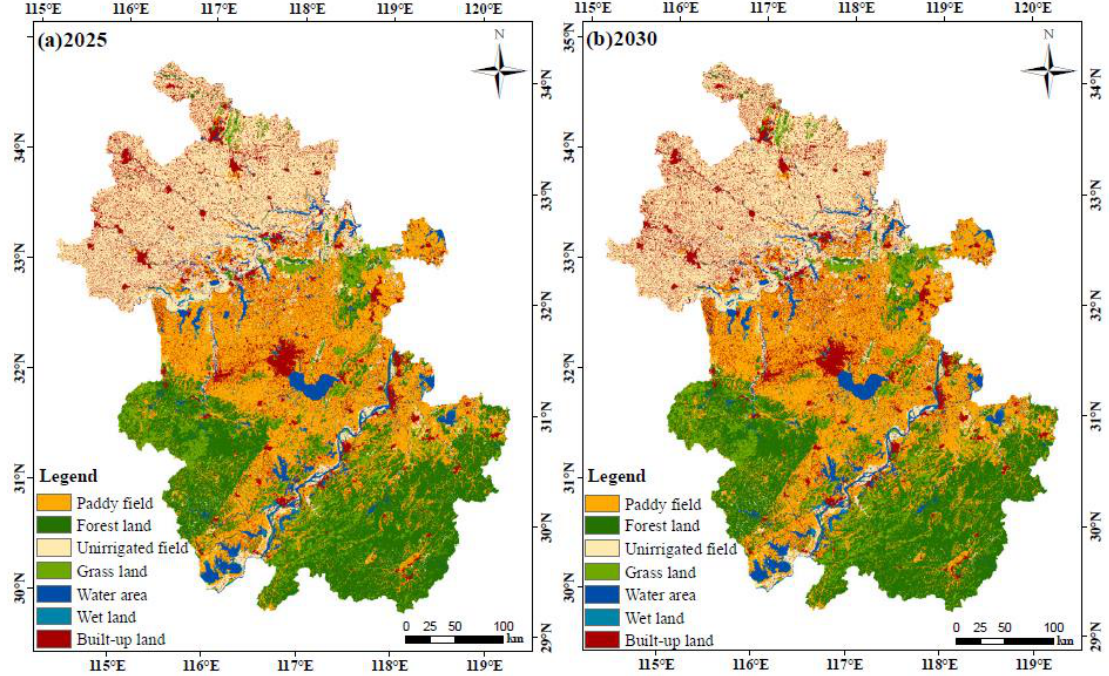
Figure 5. Simulation results of land use spatial layout in ( a ) 2025 and ( b ) 2030 using the FLUS model. Table 13. Simulation results of land use change in 2025 and 2030.